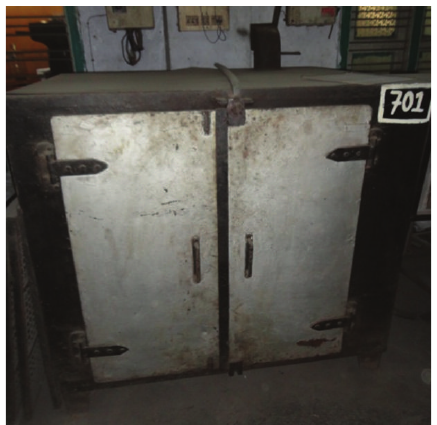
Figure 5: Postcuring apparatus.